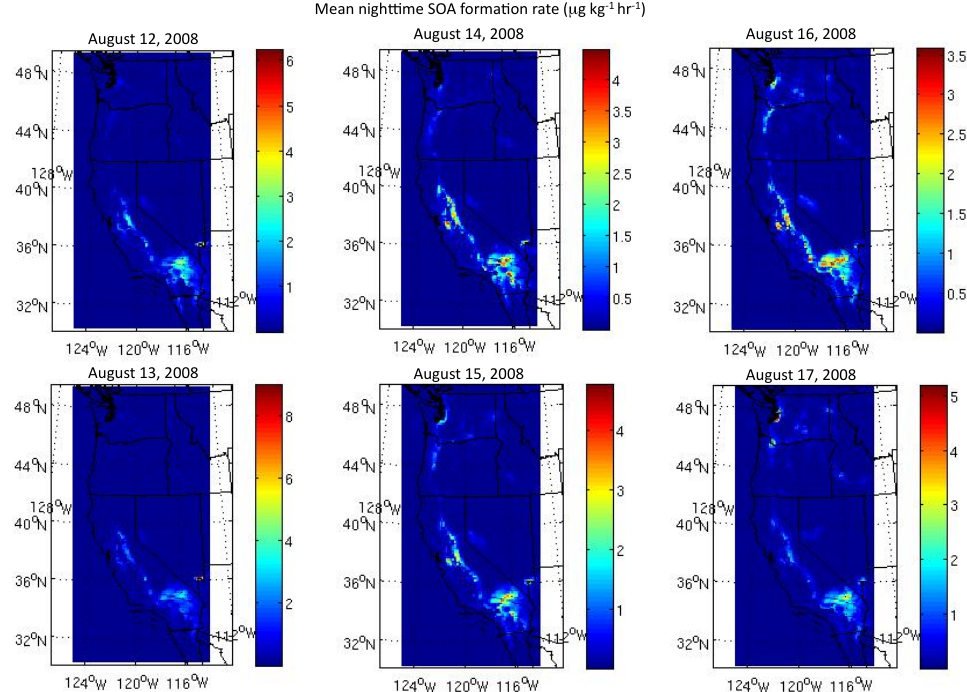
Fig. 7. Several individual nights’ averages of the NO 3 -initiated SOA source, showing spatial and magnitude variability for the western United States domain.